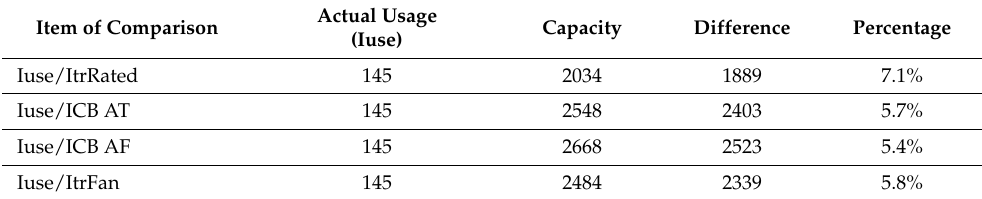
Figure 4. Comparison of ratios between actual usage and capacity of electrical appliances.